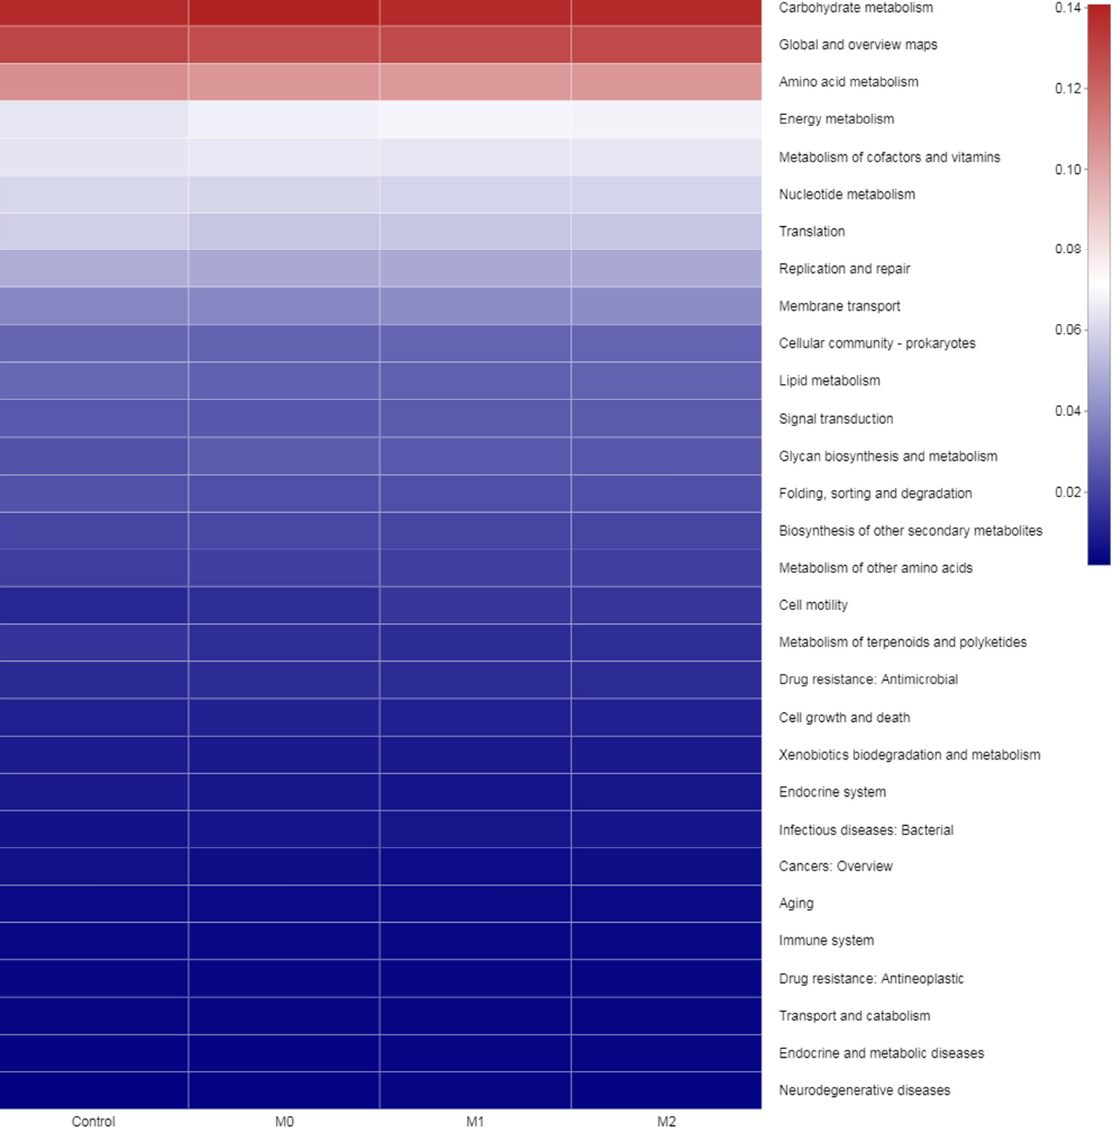
Figure 8. Top KEGG enriched pathways in different treatment groups.